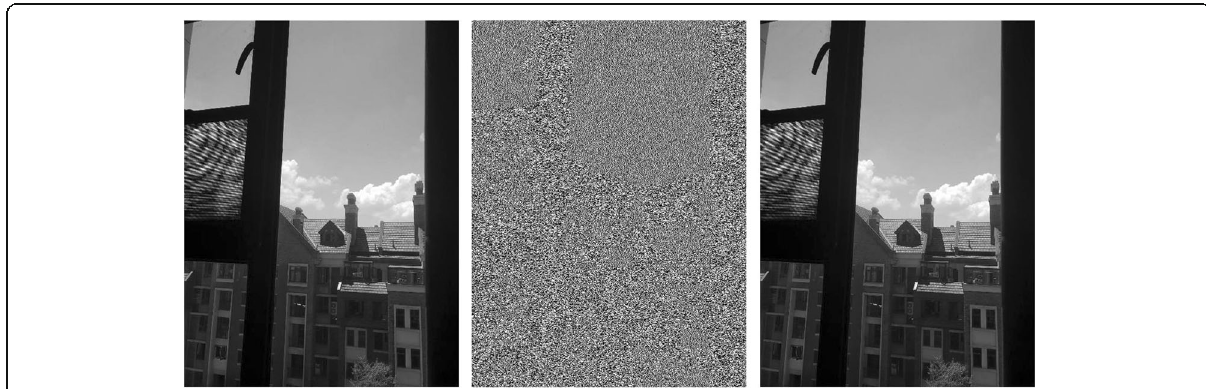
Fig. 3 Image encryption and decryption process diagram comparison. (The left is the original image, the middle is the encrypted image, the right is the decryption map)